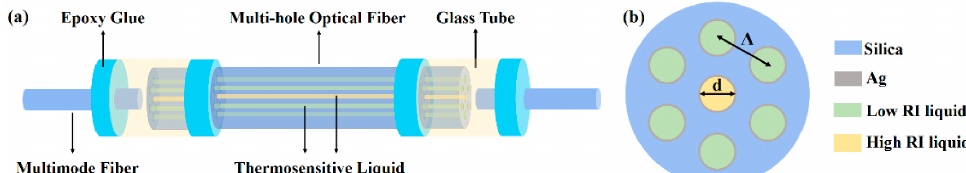
Figure 8. ( a ) Schematic diagram of the proposed SMHOF temperature sensor. ( b ) The cross-section of the SMHOF filled with thermo-sensitive liquids [reprinted with permission from [100] © The Optical Society].